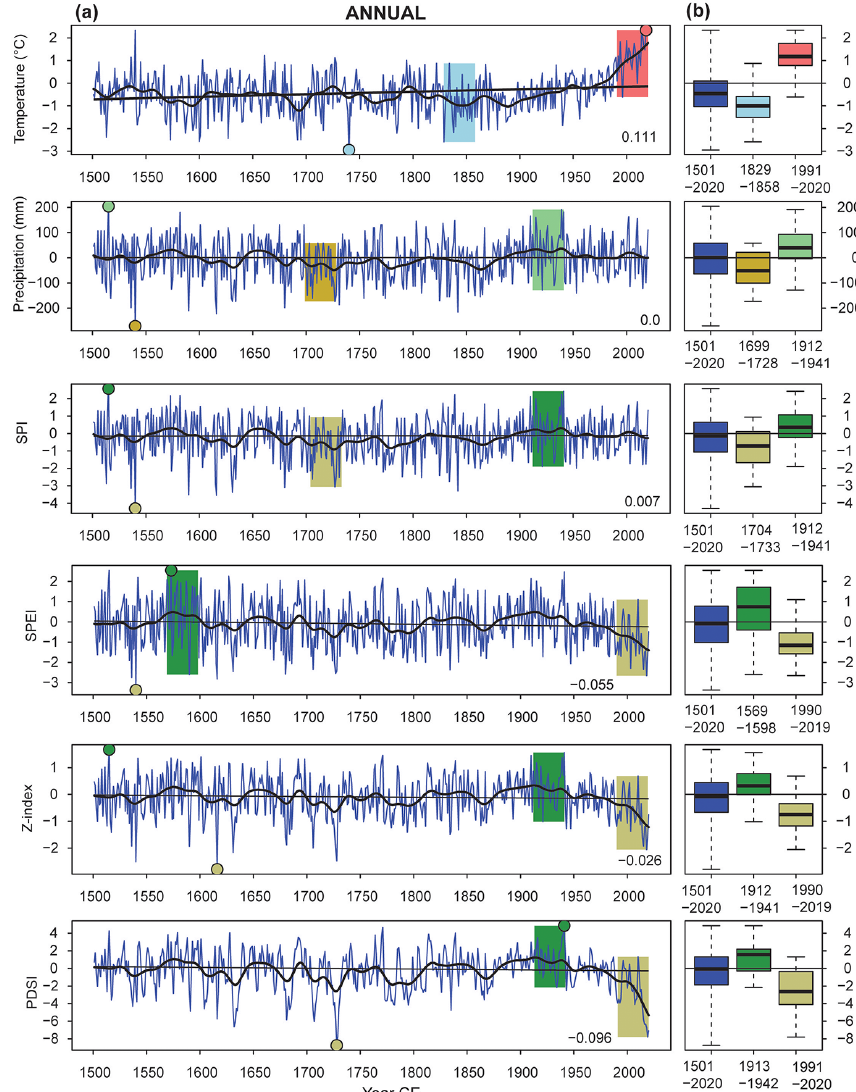
Figure 1. Selected annual climate variables in the Czech Lands during the period of 1501–2020CE: (a) fluctuations smoothed by a 30-year Gaussian filter with linear trends and their numeric values (temperature: ◦ C per 100 years, precipitation: millimetres per 100 years, drought indices: index value per 100 years); extreme 30-year periods of each series are indicated by coloured bands and the lowest and highest values of series by small circles. (b) Box plots (median, lower and upper quartile, minimum, and maximum) for 1501–2020 and the two most extreme 30-year periods. The temperature and precipitation series are expressed as deviations with respect to